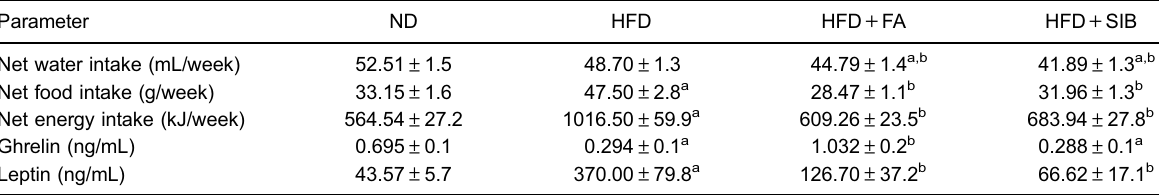
Data are reported as means ± SE (n=8). ND: normal diet; HFD: high-fat diet. a P o 0.05 vs ND; b P o 0.05 vs HFD (ANOVA and Student- Newman-Keuls test).